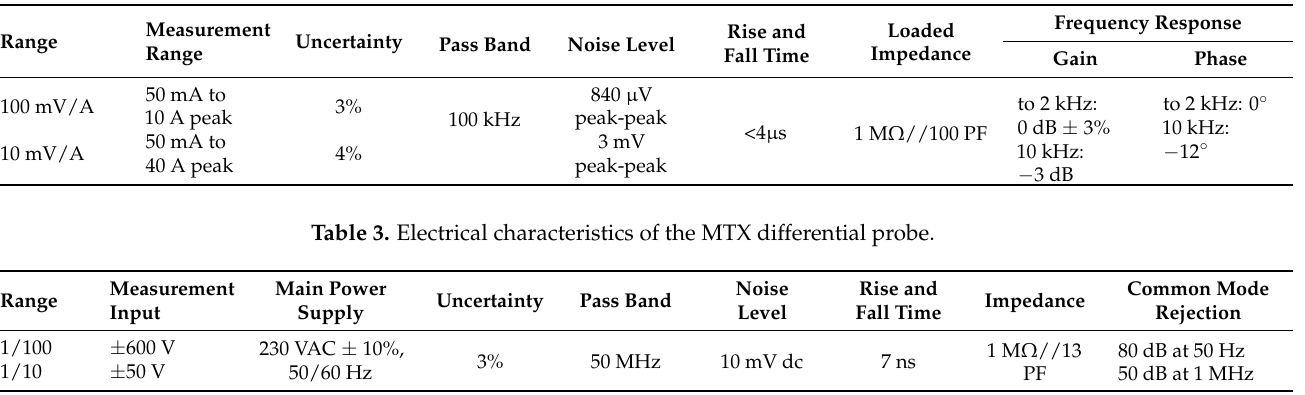
Table 2. Electrical characteristics of the E3N current clamp.